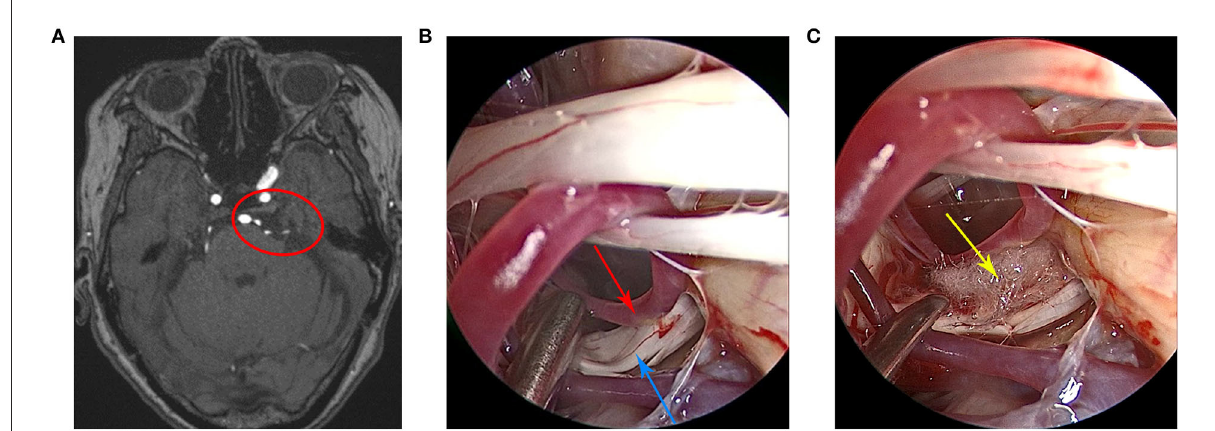
FIGURE3 (A) Preoperative head magnetic resonance imaging of the patient. (B) The trigeminal nerve and the anterior cerebellar artery were clearly visible under the endoscopic view. (C) The Teflon pad was placed between the trigeminal nerve and the anterior cerebellar artery under the endoscopic view. The red circle indicates that the trigeminal nerve was compressed by the anterior cerebellar artery, the red arrow indicates the anterior cerebellar artery, the blue arrow indicates the trigeminal nerve, and the yellow arrow indicates the Teflon